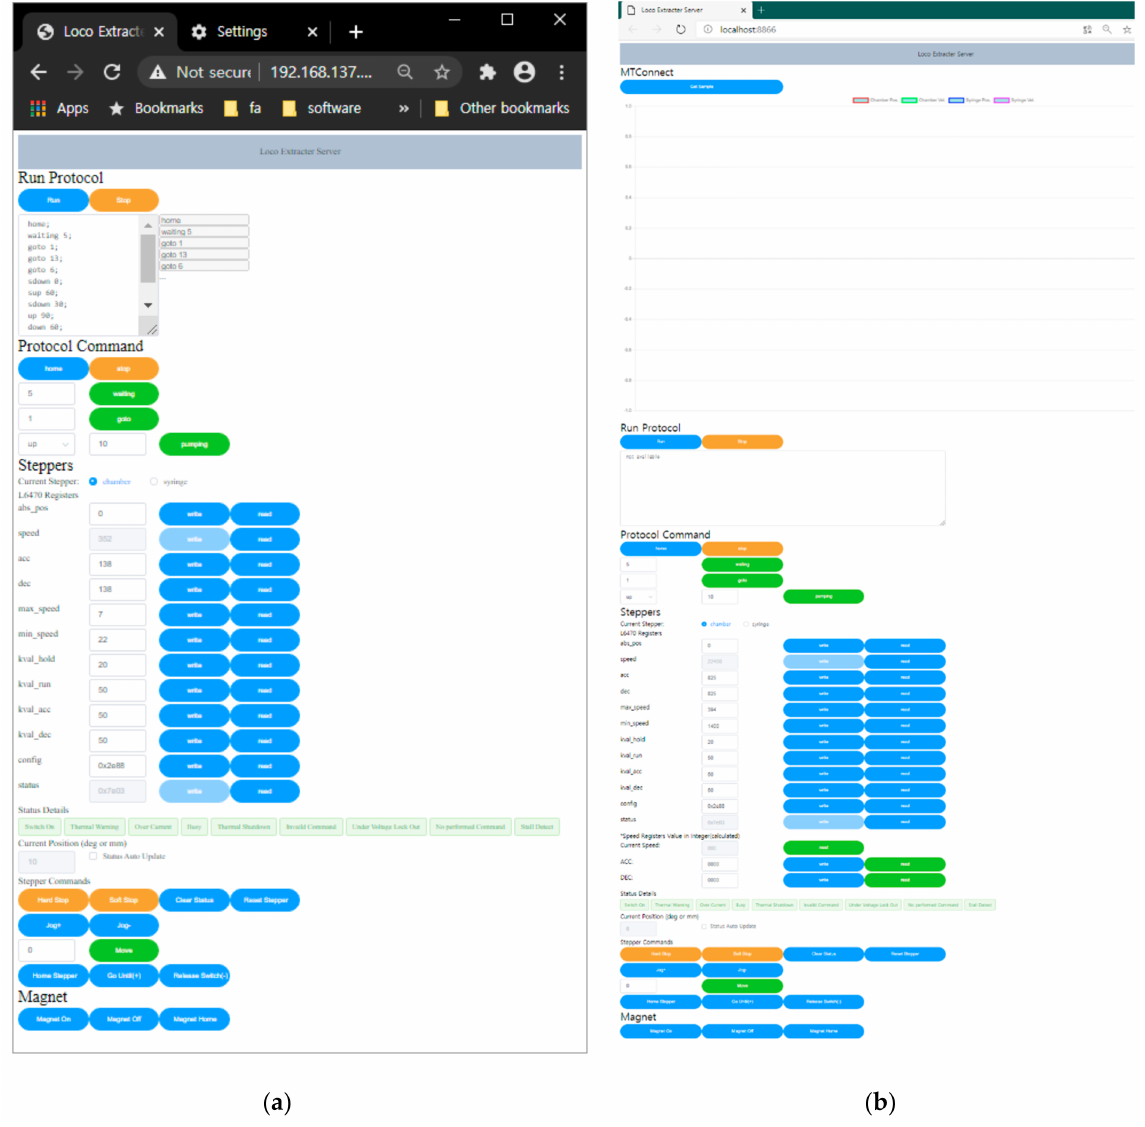
Figure 9. ( a ) Web application of DNA extraction system control; ( b ) MTConnect monitoring client web